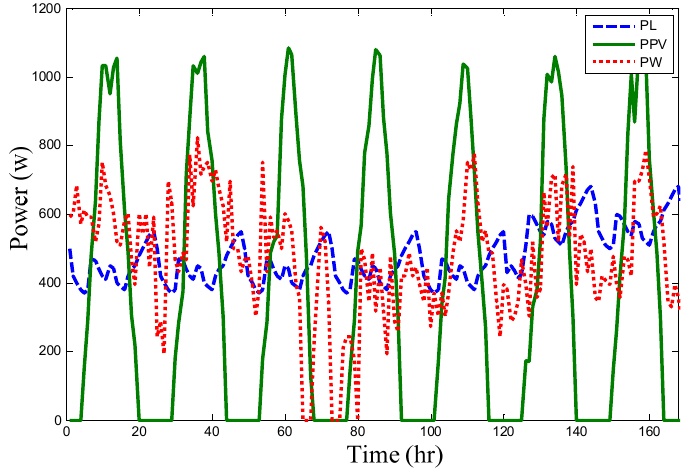
Figure 10. The power curves of the power system in the first week of June.